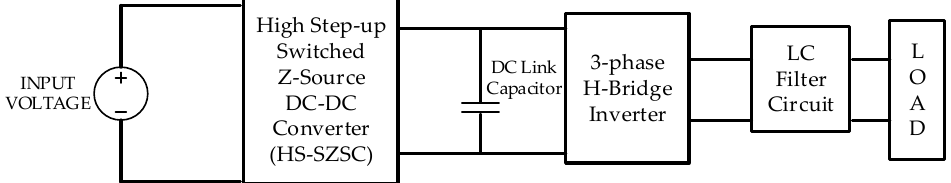
Figure 4. Proposed HS-SZC interfaced with 3-phase